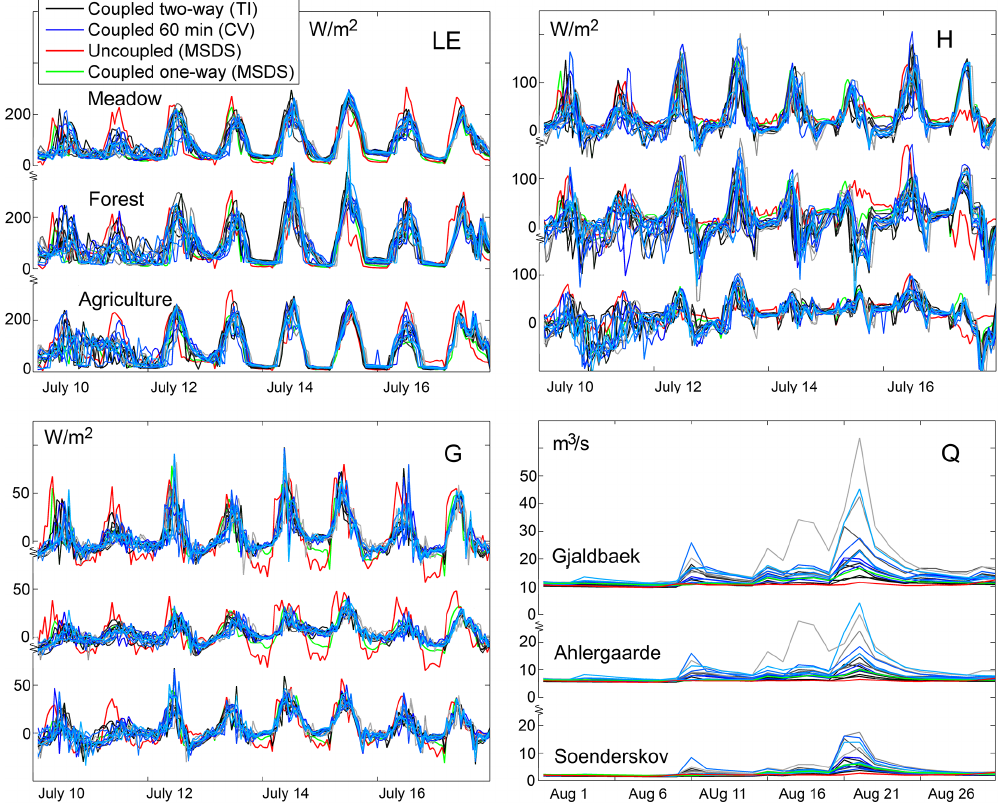
Figure 9. Four MIKE SHE output variables for the period 10–17 July (discharge is 1–31 August) for the TI, CV and MSDS runs and for Dom1 (nine cell mean). The legend colouring reflects the overall simulation group (TI, CV and MSDS) and each simulation has the same colour shade as in Fig. 6. The individual flux sites are shown for LE only. Notice the y axis shifts to accommodate more sites.